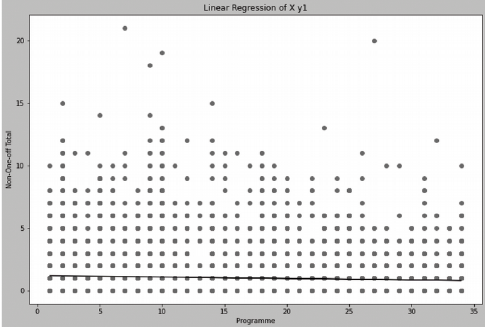
Figure 13. Linear Regression of X y1 in Finding 2